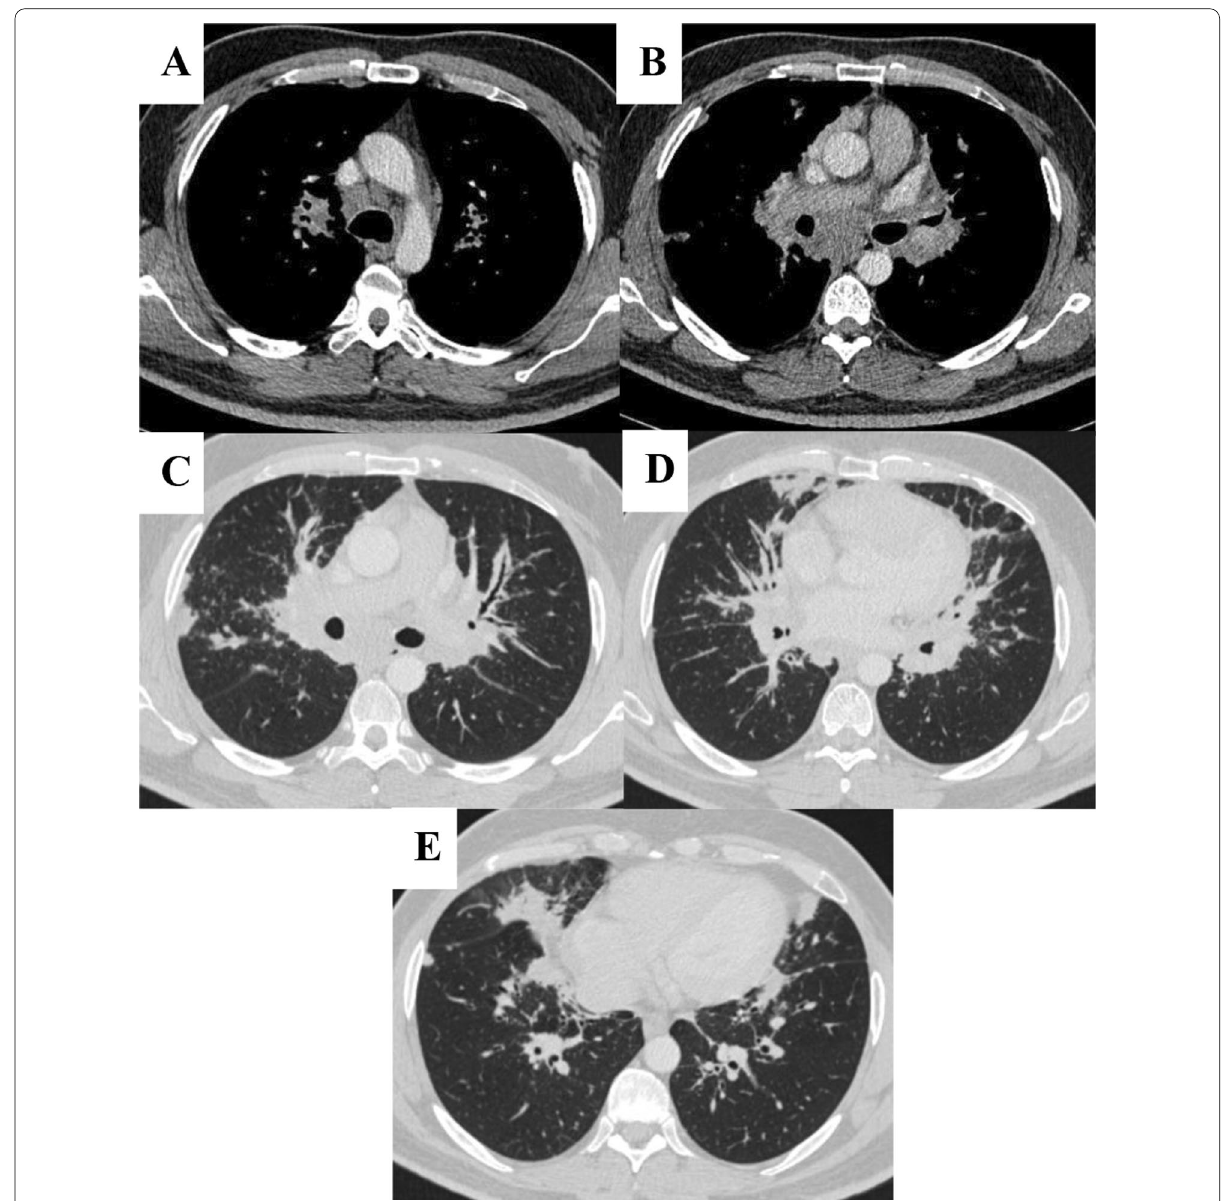
Fig. 7 A 33-year-old male complaining of persisted dry cough, wheezing and dyspnea. HRCT of the chest in a, b axial mediastinal window showing mediastinal and bilateral hilar lymphadenopathy, and c – e axial lung window images showing bilateral well-defined centri-lobular and peri-lymphatic nodules involving multiple lobes with nodular septal thickening and beaded fissures. The diagnosis of sarcoidosis was